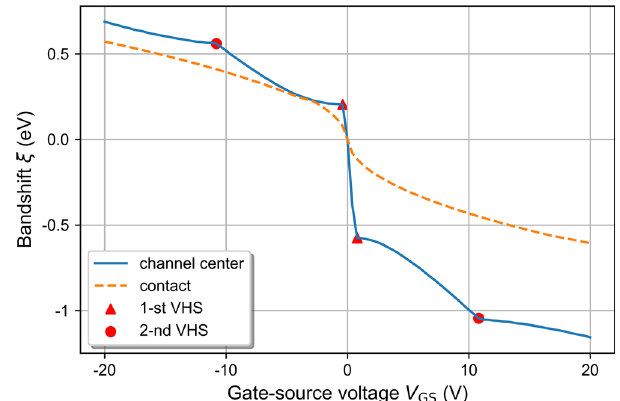
Fig. 3 Gate ef fi ciency in the center of the channel and the contact region. The gate induced shift of the energy bands ξ in the channel center (solid blue line) and the contact region (dashed yellow line) as a function of the gate-source voltage V GS . Compared to metallic electrodes, the graphene electrodes cannot entirely screen the carbon nanotube (CNT) from the gate fi eld, whereby the CNT can also be electrostatically doped in the contact region. We explain the almost linear behavior of the band shift in the channel center by the fact that the Fermi level lies within the bandgap of the CNT, where the quantum capacitance is zero. For slightly increased (decreased) gate-source voltages, the linear behavior is damped rapidly because the Fermi level reaches the fi rst van Hove singularity observe a strongly nonlinear response. The cusps, which originate from the van-Hove singularities, are annotated by the red mar- kers in Fig. 3. In the contact region, we do not see any linear behavior. This is because graphene is a semi-metal and the partial screening of the CNT occurs even at small voltages.